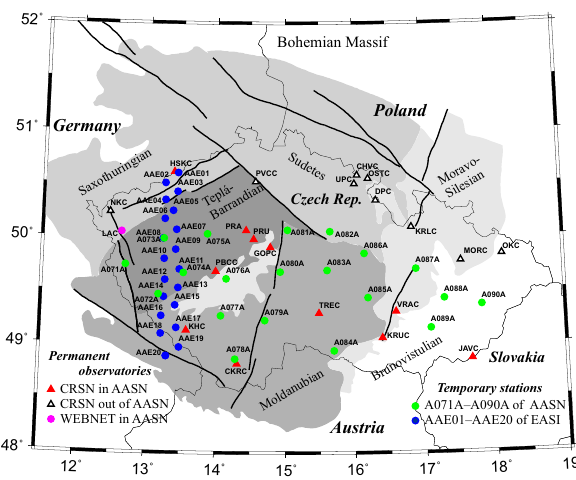
Figure 2. Schematic map of major tectonic units of the Bohemian Massif and seismic stations of the MOBNET pool involved in the network of the AlpArray-EASI complementary project (blue cir- cles) and the AlpArray Seismic Network (AASN, green circles) of the AlpArray project. CRSN – Czech Regional Seismic Network (Institute of Geophysics, 1973); WEBNET – West Bohemia Seis- mic Network (Institute of Geophysics,